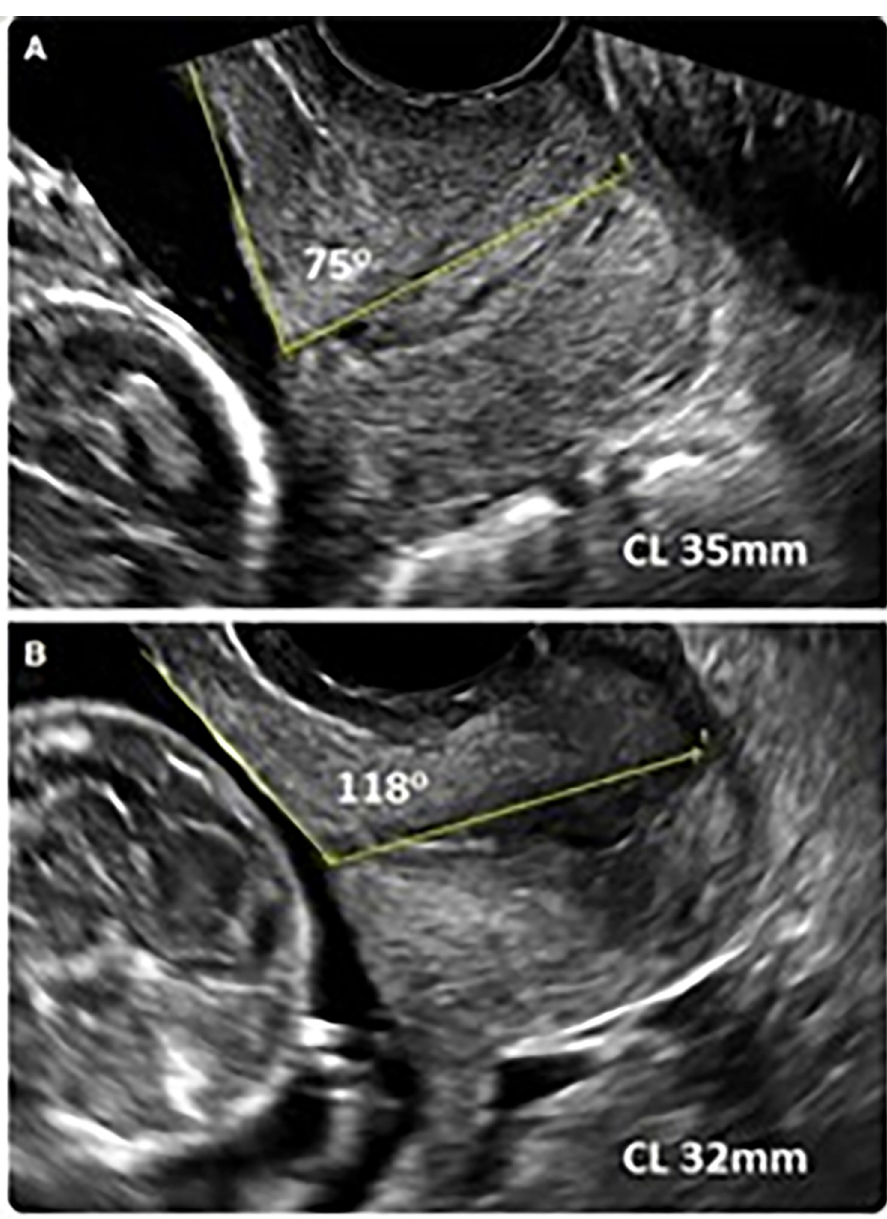
Fig 3. The measurement of UCA. From